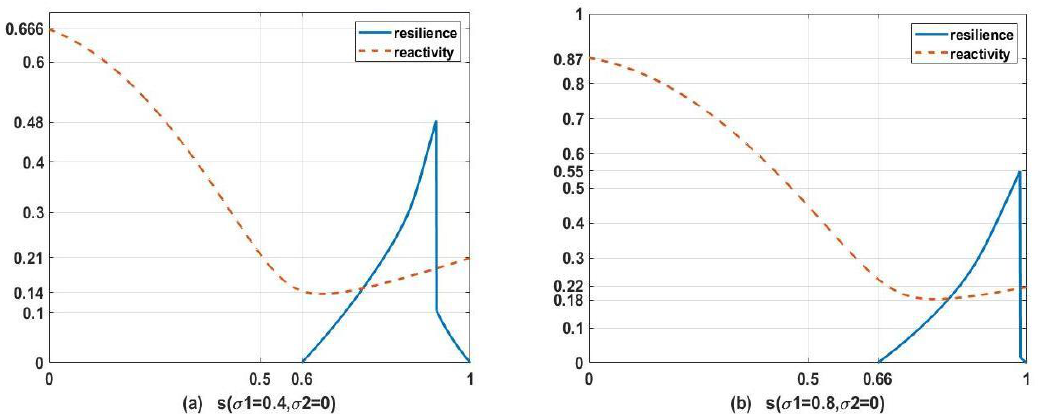
Figure 5. Resilience and reactivity of the system (7) when the prey is disturbed (in the mean square sense).